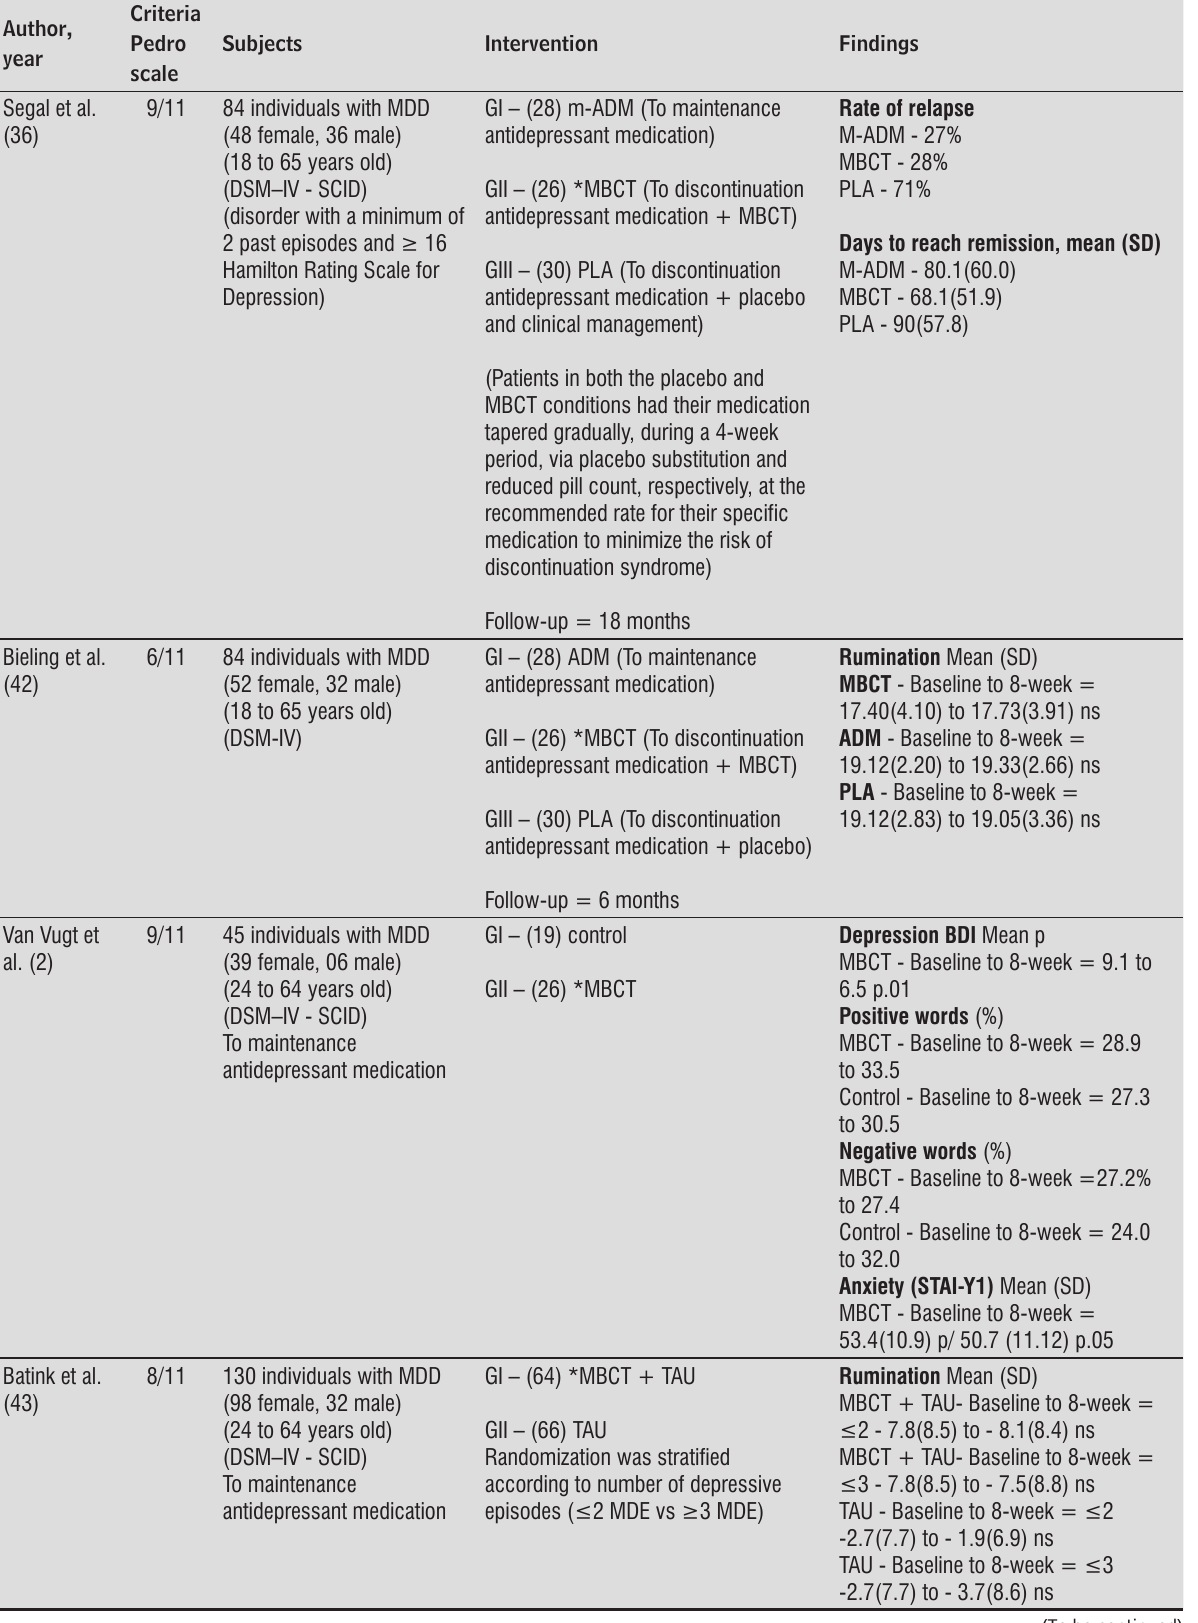
Table 2 - Characteristics of the studies Interventions